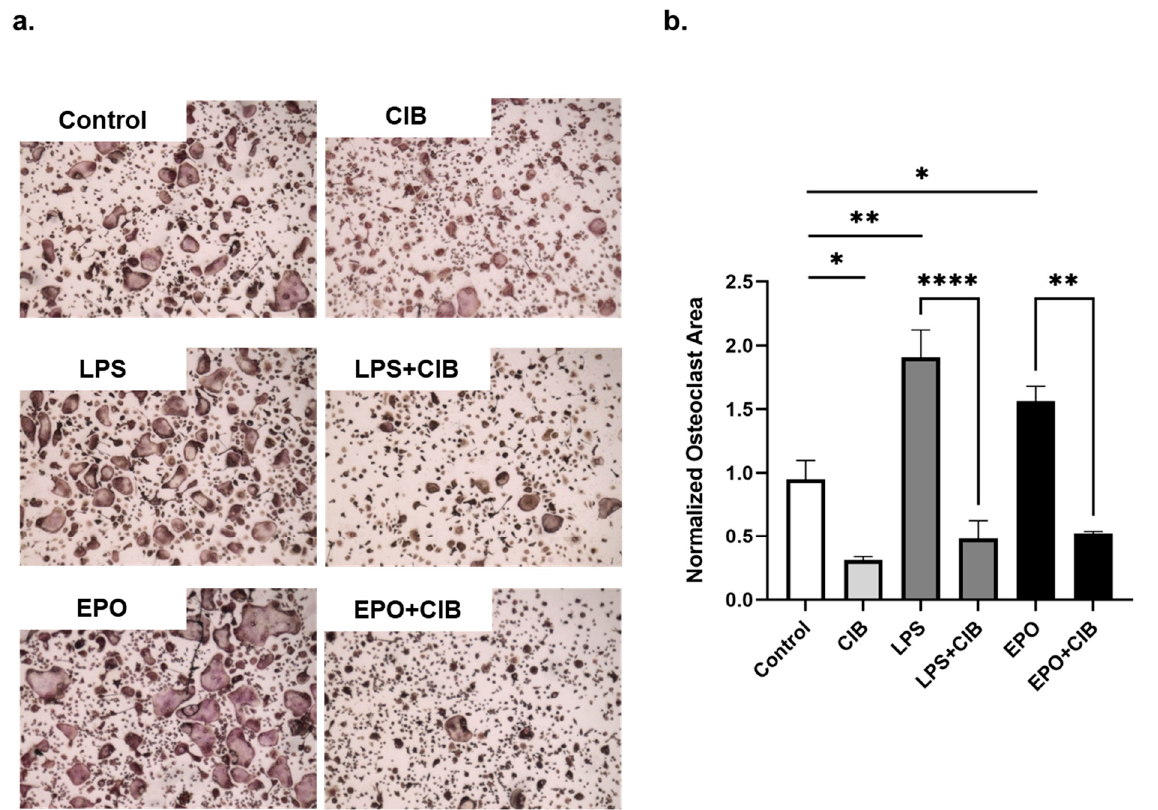
Figure 4. Cibinetide (CIB) counteracts the effect of EPO on preosteoclasts in vitro. BMDMs were treated with RANKL (50 ng/mL) along with EPO (10 U/mL), Cibinetide (150 μ M), or EPO + Cibinetide. On the second day, LPS (10 ng/mL) was introduced to the RANKL or to the RANKL + Cibinetide cultures. On the fourth day, the multinucleated osteoclasts were stained for TRAP. ( a ) Representative micrographs of TRAP + osteoclasts. Original magnification at 2×. ( b ) Quantification of the total area of TRAP + multinucleated cells that were normalized to the values of the control group (RANKL). The data are mean ± SEM of three independent experiments. * p < 0.05, ** p <0.01, **** p < 0.0001.